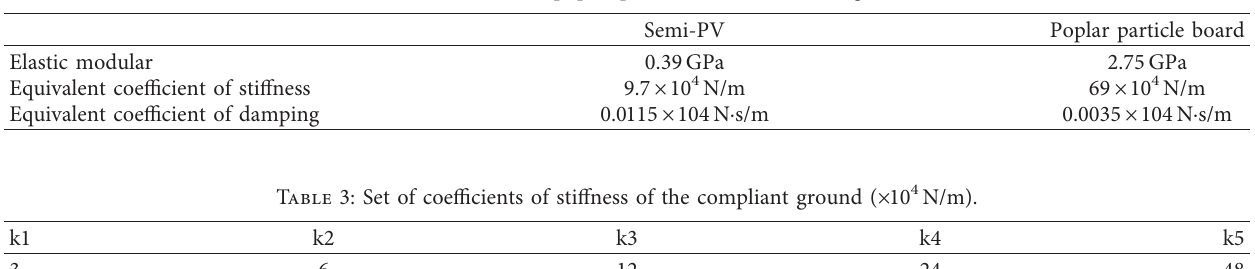
Figure 4: The prototype Table 2: Parameters of 4mm poplar particle board and semirigid PVC mat.